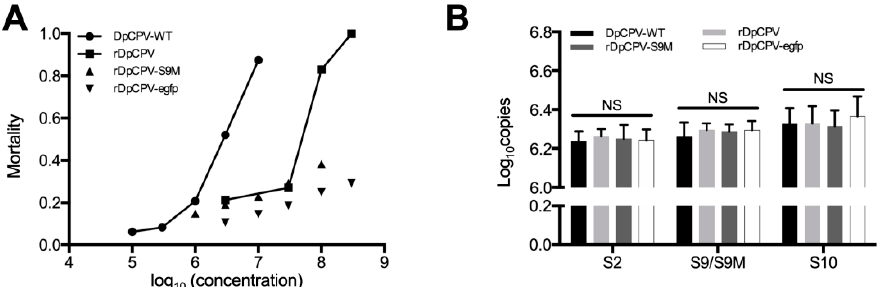
Figure 6. Comparison of virulence and gene copy numbers between DpCPV-WT and recombinant DpCPVs. ( A ) S. exigua larvae were infected with different concentrations of DpCPV-WT, rDpCPV, rDpCPV-S9M and rDpCPV-egfp. Mortality induced by viruses was related to the concentrations